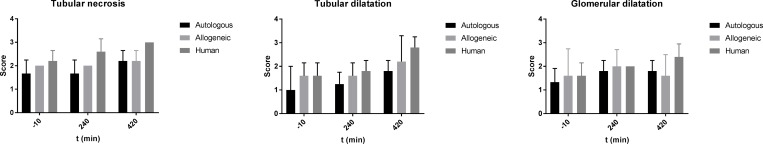
Histological damage scoring of cortical biopsies taken at t = -10, t = 240 and t = 420 (mean ± SD).